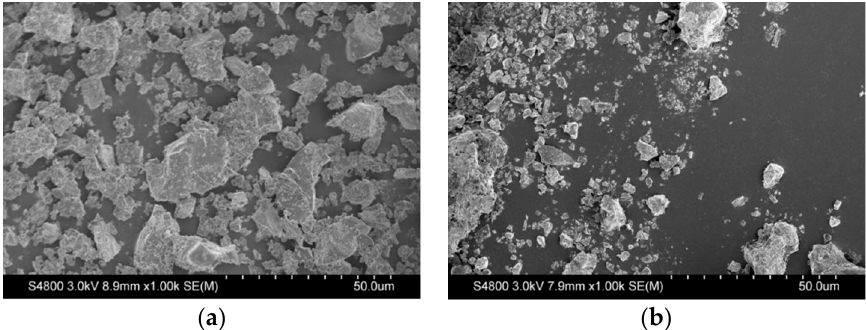
Figure 4. A micrograph of cement and recycled brick powder. ( a ) Cement; ( b ) Recycled brick pow- der.